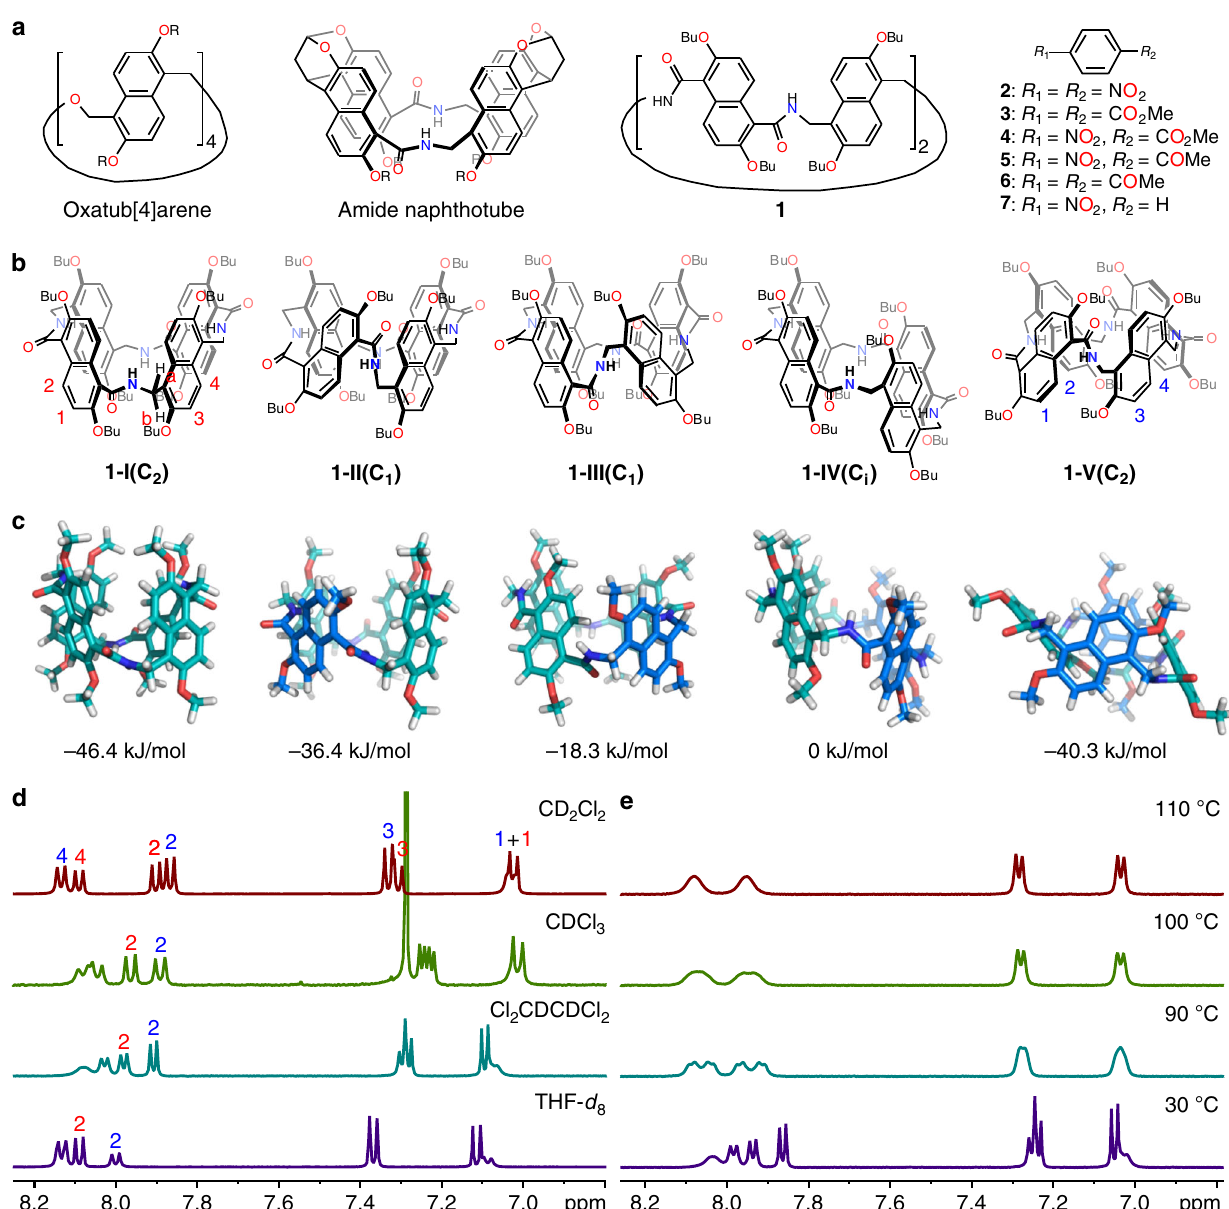
Fig. 2 Chemical structures of all the related compounds and conformational analysis of macrocycle 1. a Chemical structures of oxatub[4]arene, amide naphthotube, macrocycle 1 and all the guests involved in this research. b Chemical structures of the fi ve conformers of macrocycle 1 . Colored numbering on the structures corresponds to the assignment of NMR signals for different conformations. c Energy-minimized structures of the fi ve conformers calculated by DFT at the wB97XD/6-31 G(d) level of theory. d Partial 1 H NMR spectra (500 MHz, 25 °C) of 1 in different deuterated solvents. e Variable-temperature 1 H NMR spectra of 1 in Cl 2 CDCDCl 2 (600